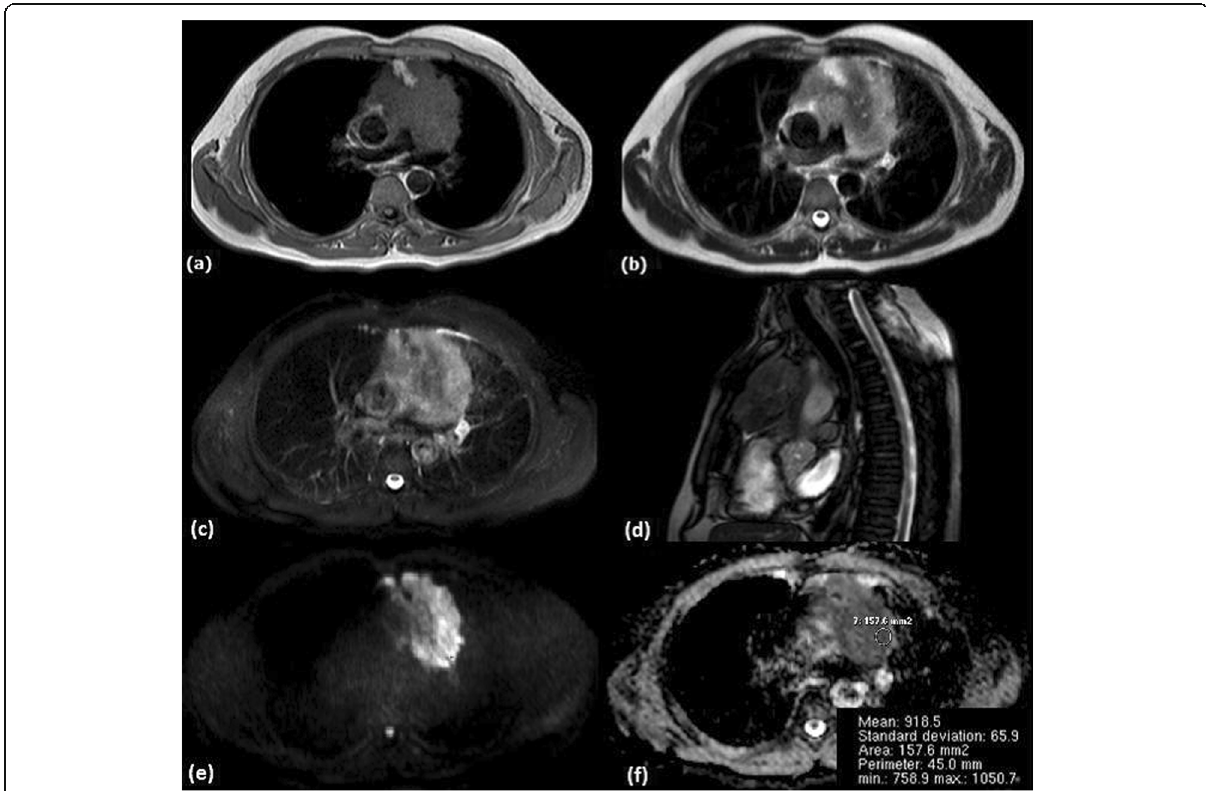
Fig. 6 Hodgkin lymphoma: A 51-year-old male with an anterior (prevascular) mediastinal mass identified on CT. The patient clinically presented with constitutional symptoms (unexplained fever and weight loss), dyspnea, cough, and retrosternal chest pain. a Axial T1 WI, b axial T2 WI, c axial STIR WI, and d sagittal BFFE WI show a well-defined ovoid-shaped anterior mediastinal mass displaying intermediate T1 and heterogeneous T2 and STIR signal intensities. The mass shows restricted diffusion; with the predominant bright areas on the e DWI corresponding to dark areas on the f ADC map. ADC mean = 0.890 × 10 − 3 mm 2 /s and ADC min = 0.624 × 10 − 3 mm 2